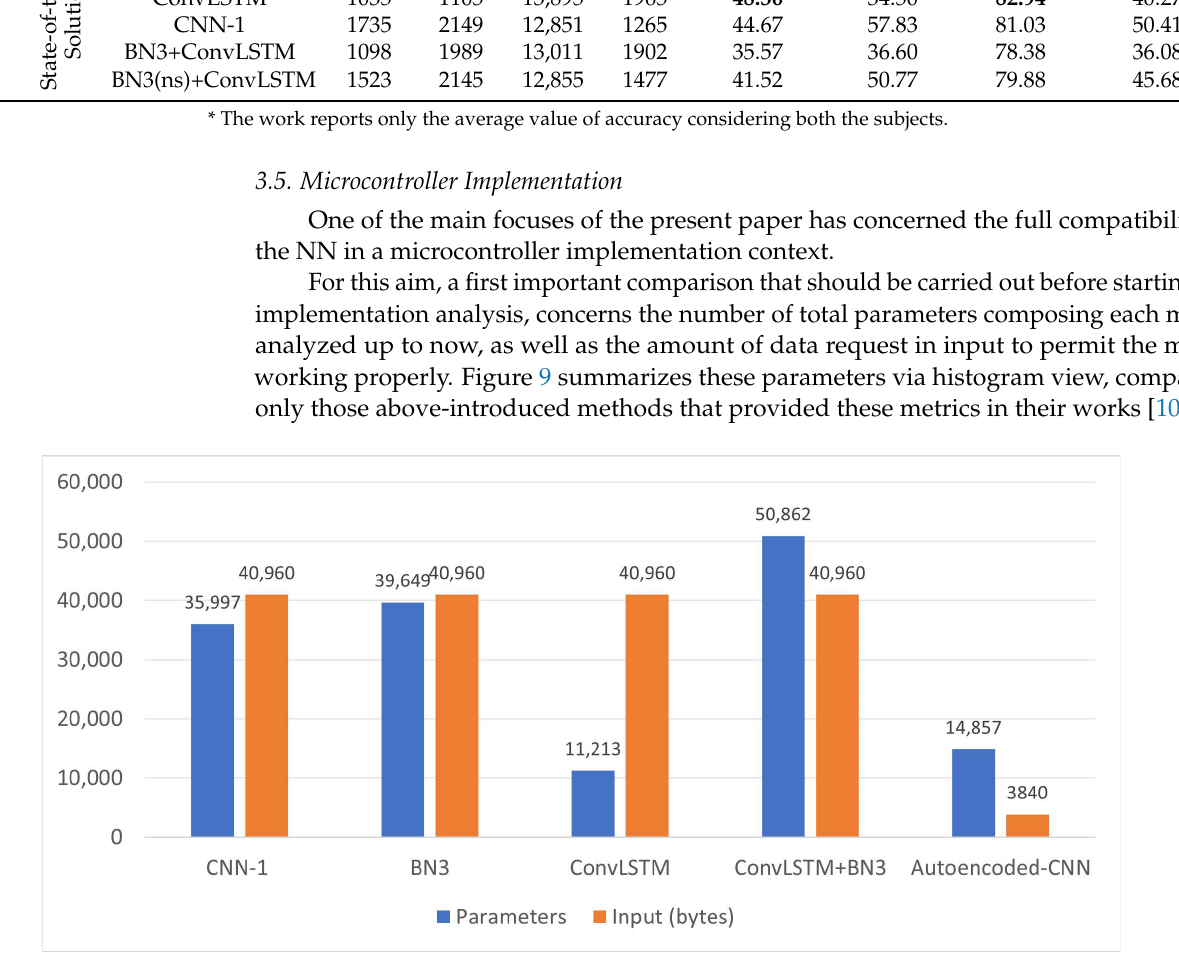
Figure 9. Histogram plot of the number of NN model parameters and input data size (bytes) for the analyzed